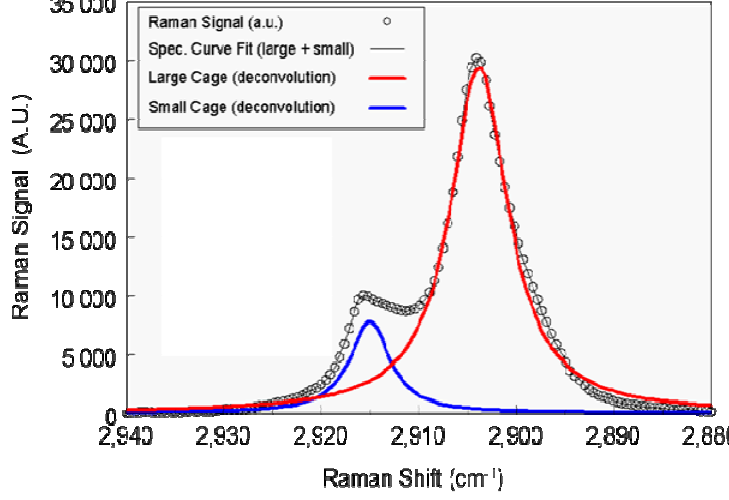
Figure 5. Typical Raman spectra representative of sI hydrate samples collected during NETL rapid hydrate formation